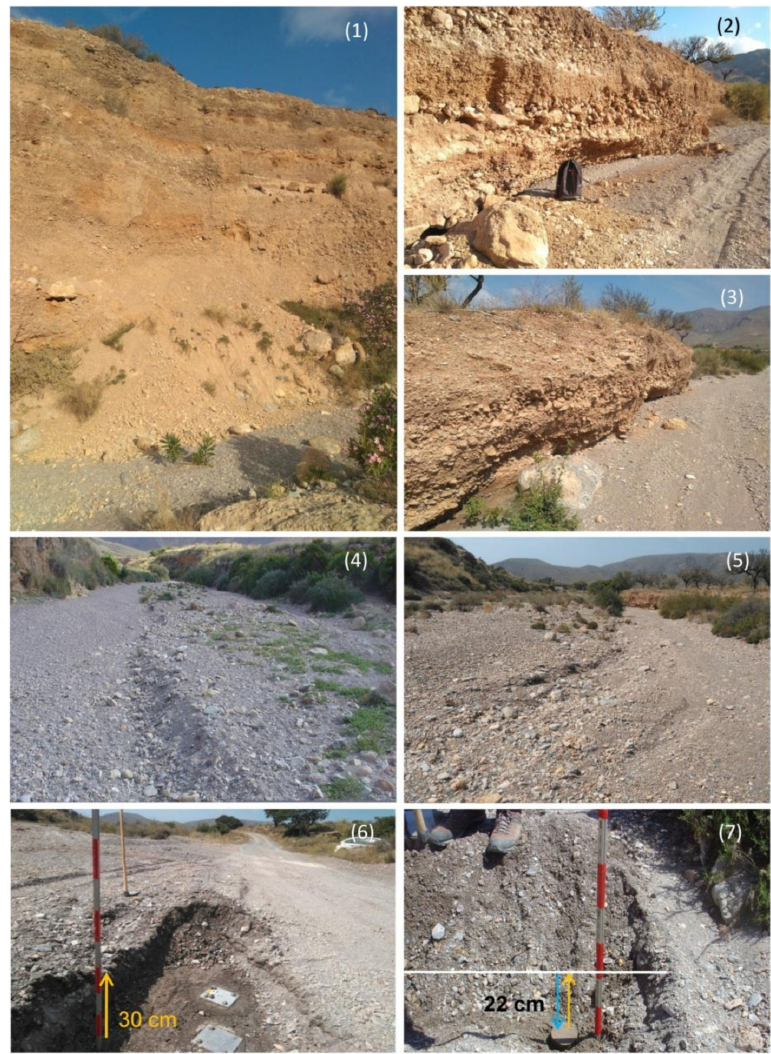
Figure 12. Local material collapses in composite detrital banks after basal undermining caused by the flash flood of April 2019 ( 1 , 2 ); entrainment and surface washing of non-cohesive basal bank deposits during the peak flow of September 2019 ( 3 ); after the larger event, greater morphological adjustments occurred: lateral accretion of central longitudinal bars in the Upper RCR ( 4 ), vertical accretion at the head of a central bar and slight incision on the thalweg bed in MDR ( 5 ), a strong net deposition between the upper and Middle RCR (see the levelogger plate that was deeply buried) ( 6 ), and high transitory erosion in the main active channel (see a clear example in the Upper RCR) ( 7